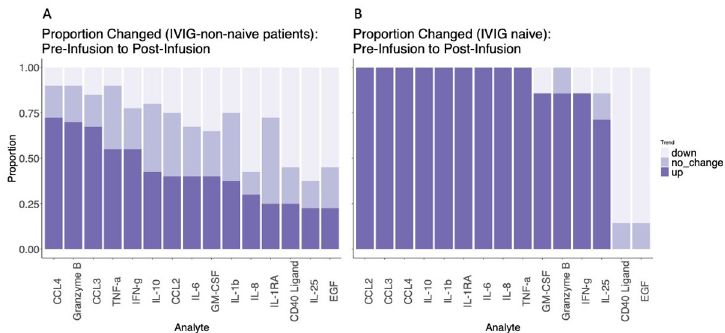
Fig 5. Proportions of intervals where cytokines change varies between cytokines. Stacked bar graph for each cytokine found to change between the pre- and post-infusion measurements; A. non-na ï ve subjects, B. na ï ve subjects. Direction of change is signified by depth of color as shown in the figure legend. "Up" signifies a greater than 10% increase and "down" signifies a greater than 10% decrease.